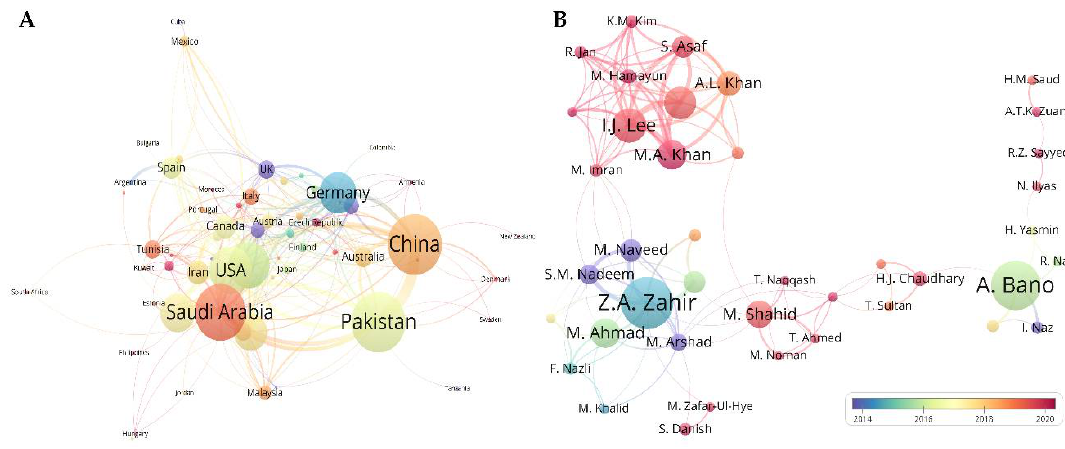
Figure 5. ( A ): intensity of cooperation among countries was generated by VOSviewer software; ( B ): a collaboration network of authors was generated by VOSviewer software. Take total link strength as the weight. The larger the total link strength, the larger the volume of the node. Lines between countries/authors indicate that they collaborated with the same researchers. The node’s color corresponds to the year when the country/author conducts more active research.